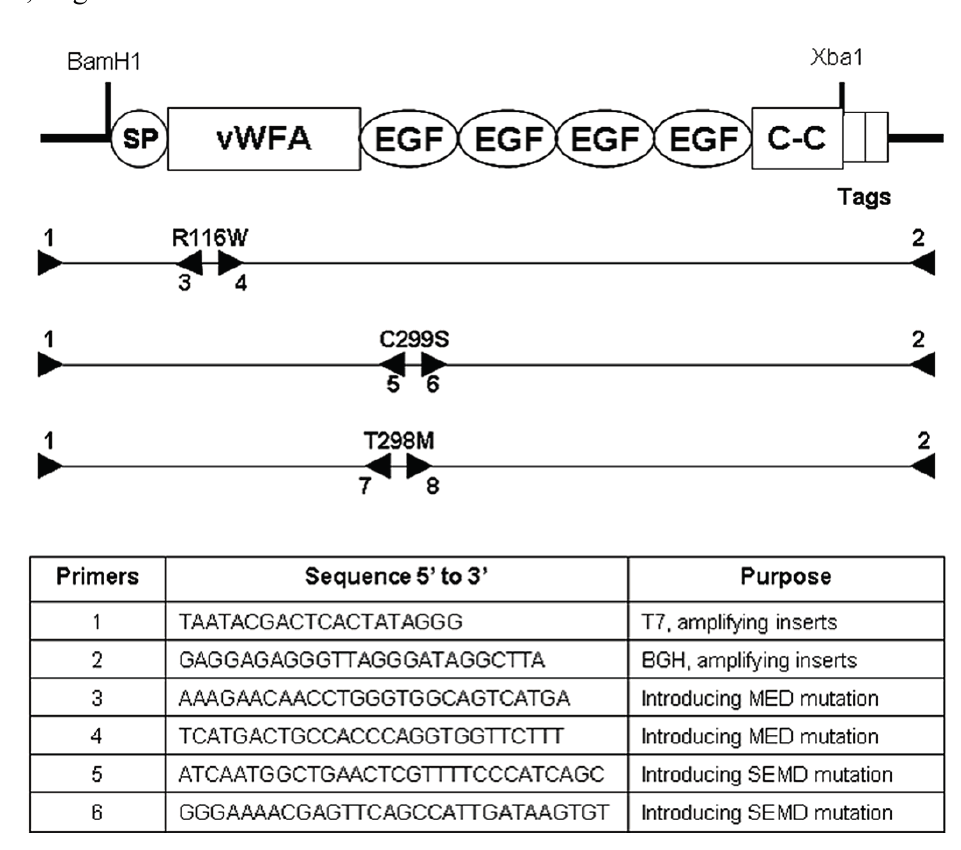
Figure 1. Generating multiple epiphyseal dysplasia (MED) and spondyloepimetaphyseal dysplasia (SEMD) mutant MATN3 gene constructs. Relative annealing locations of primers